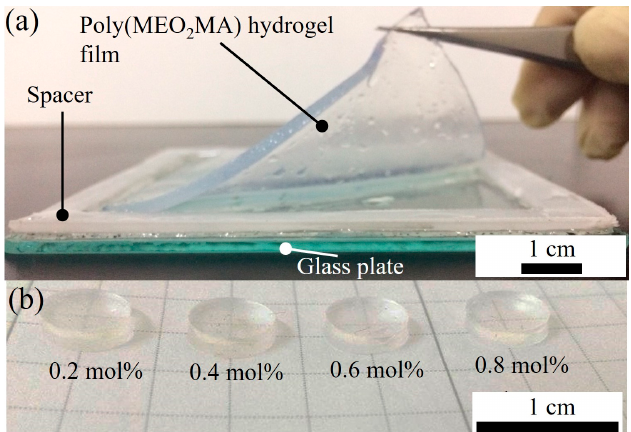
Figure 4. ( a ) Photo images of the fabricated poly(MEO 2 MA) hydrogel film by using the casting approach and ( b ) the disc-shape of poly(MEO 2 MA) hydrogel samples with four different molar feed ratios of cross-linker.